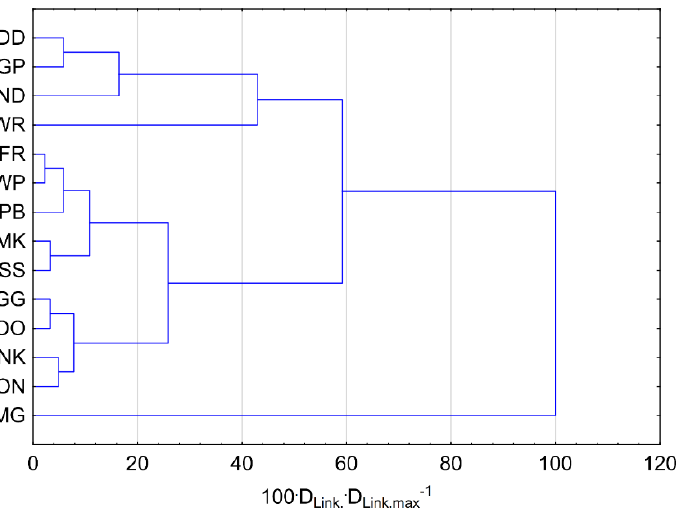
Figure 7. Results of CA based on the results of multitemporal trend analysis of yearly mean flows (YM) over the period 1951–2020.